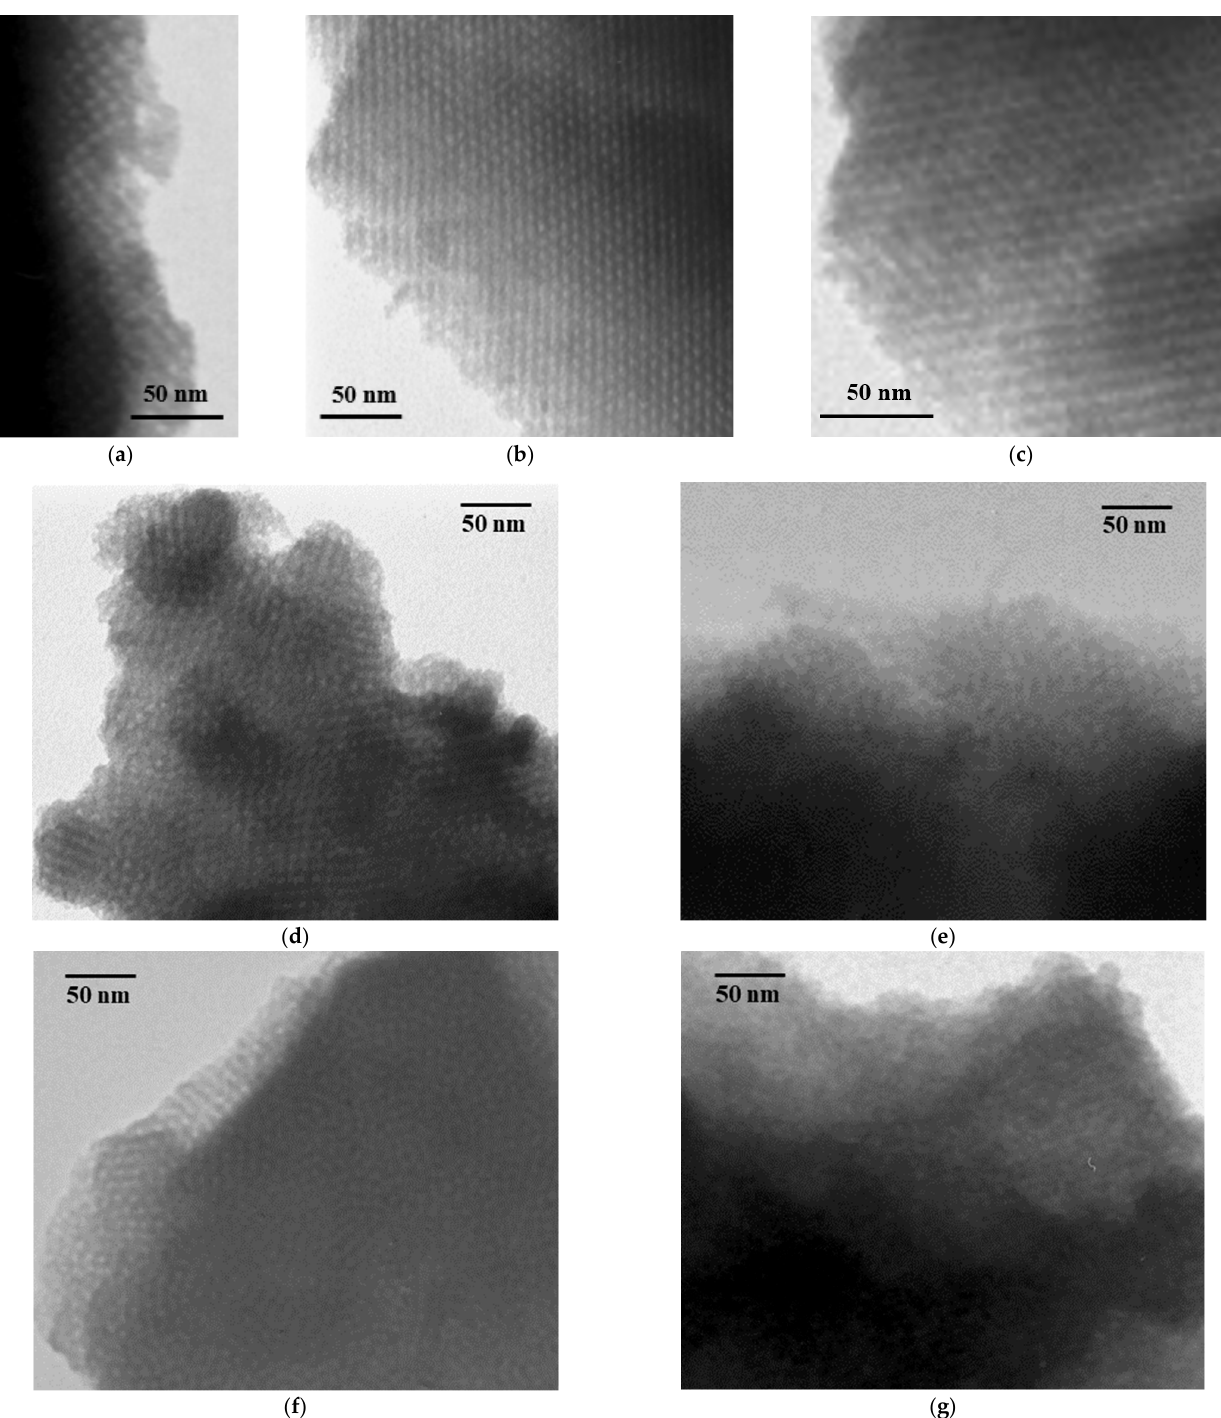
Figure 4. TEM photos of ( a ) KIT-5/K material and samples modified with sulfonic groups by graft- ing: ( b ) KIT-5/G/SH/0.100, ( c ) KIT-5/G/SO3H/0.100, ( d ) KIT-5/E material, and samples modified by ( b ) KIT-5/G/SH/0.100, ( c ) KIT-5/G/SO 3 H/0.100, ( d ) KIT-5/E material, and samples modified by co-condensation: ( e ) KIT-5/C/SO3H/0.005, ( f ) KIT-5/C/SO3H/0.050, ( g ) KIT-5/C/SO3H/0.100. co-condensation: ( e ) KIT-5/C/SO 3 H/0.005, ( f ) KIT-5/C/SO 3 H/0.050, ( g ) KIT-5/C/SO 3